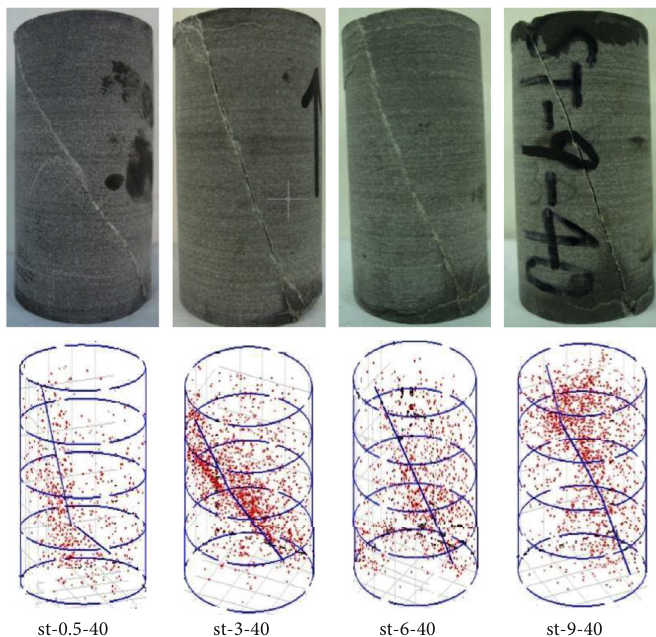
Figure 20: Positioning results of acoustic emission test and broken rock sample under di ff erent hydraulic loading by Wang and Shrive